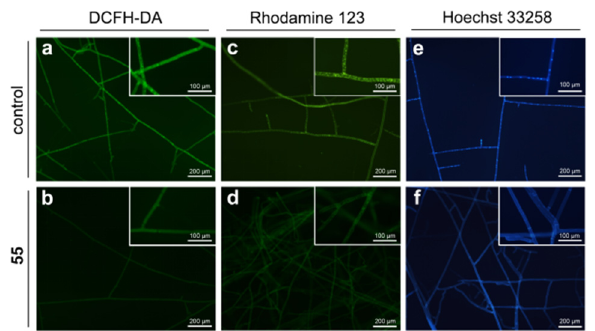
Figure 7. The mode of action of 55 against R. solani . ( a , b ) The intracellular ROS generation of the hyphae was detected by fluorescent micrographs using DCFH-DA staining; ( c , d ) The mitochondrial membrane potential of the hyphae was evaluated by fluorescent micrographs with Rhodamine 123 staining; ( e , f ) nuclear morphology of R. solani hyphae stained by Hoechst 33258.